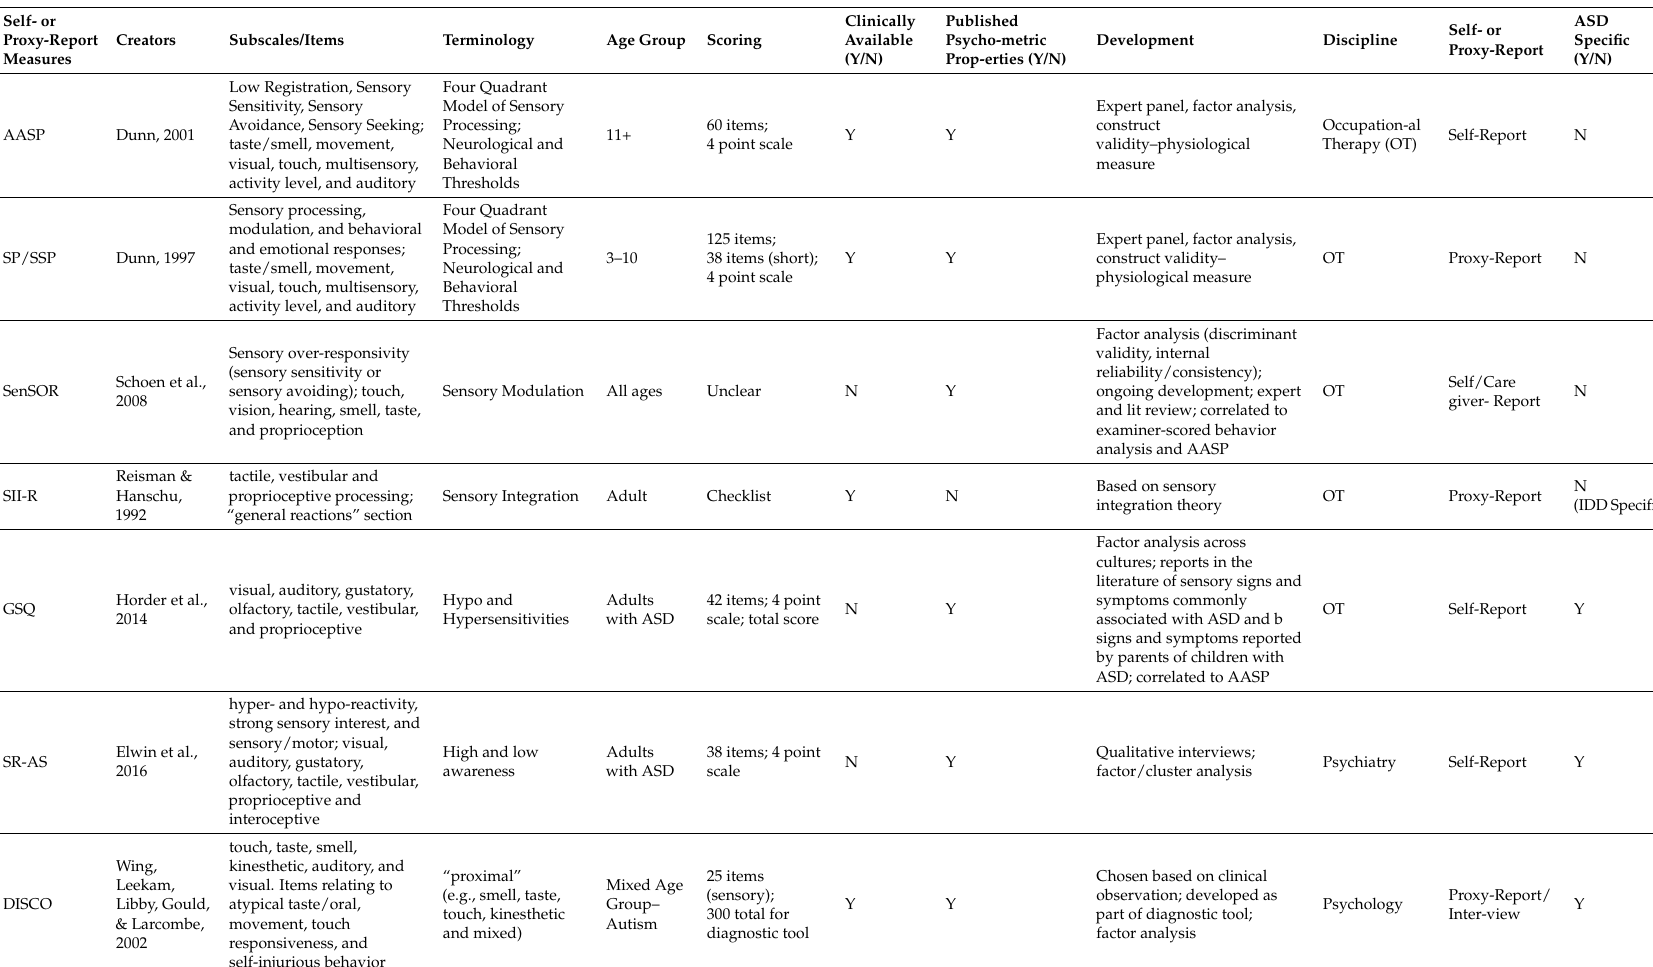
Table 3. Sensory Processing Questionnaires Applied to Adults/Adolescent